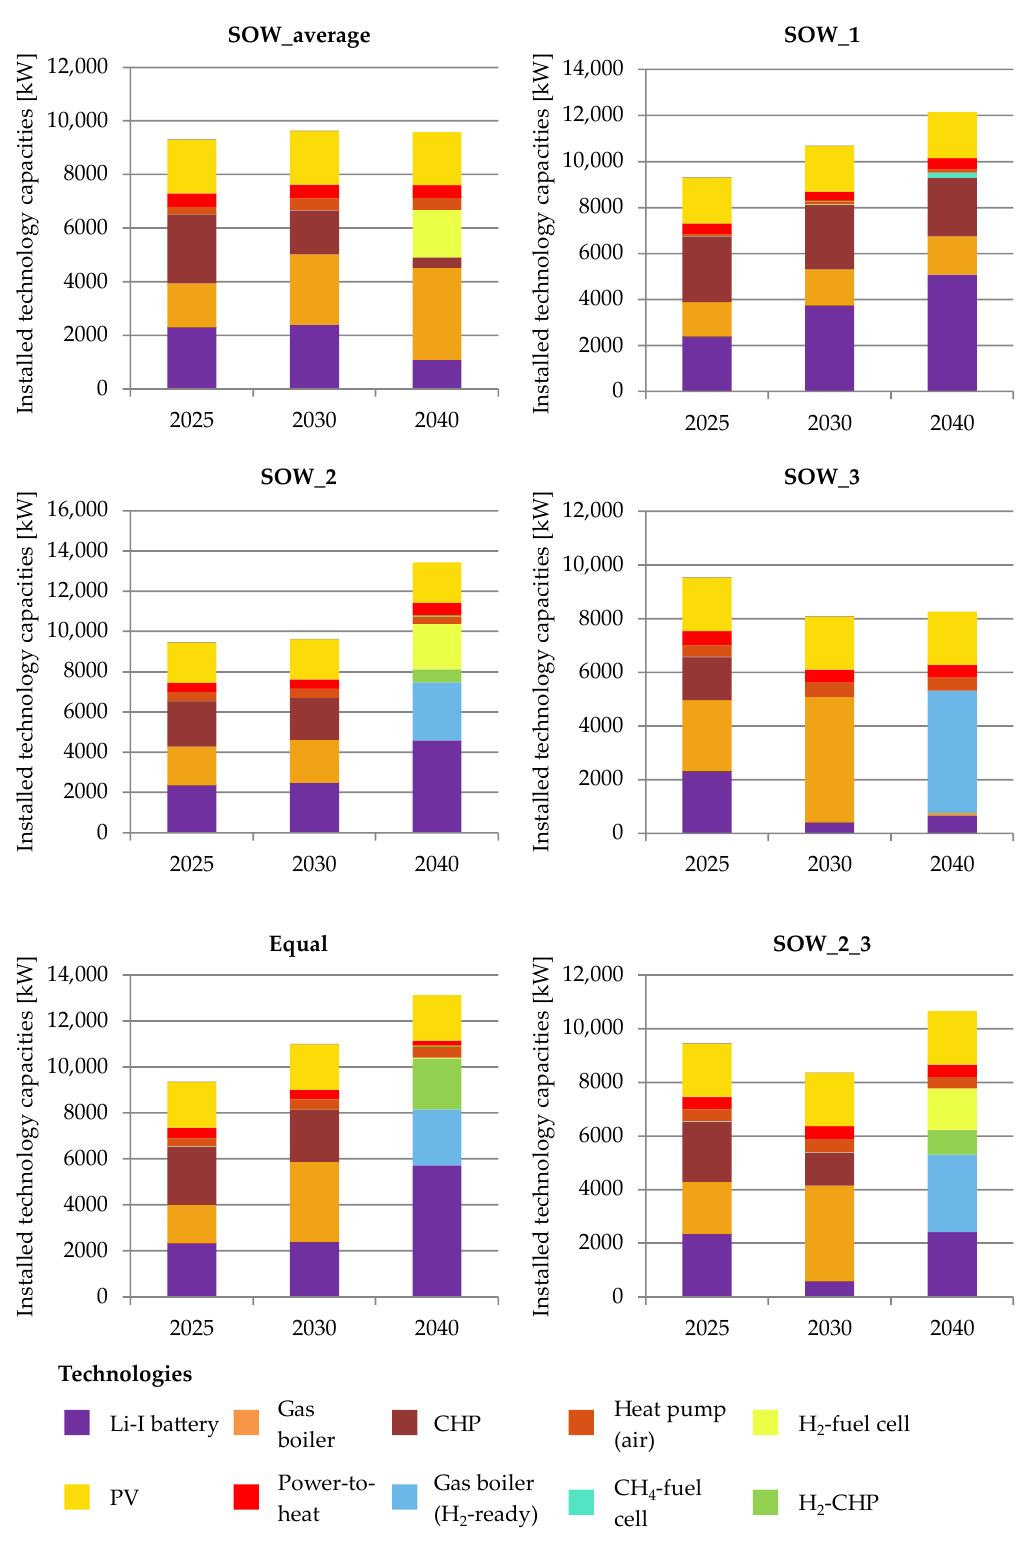
Figure 21. Installed technologies for different myopic scenarios (myopic, without CCS). If the installed technologies of Figure 21 are compared with the installed technologies of the scenarios with the option for CCS (Appendix B), it is visible that CCS does not play an important role. Each scenario, independent of the availability of CCS, builds around another predominant energy system structure (Figure 21 and Appendix B) and